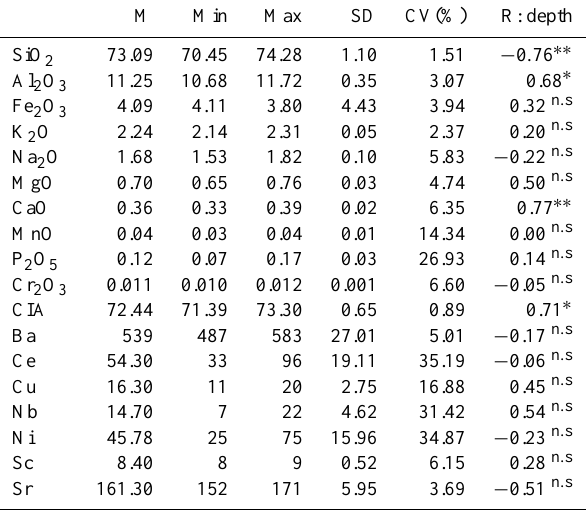
Table 3. Descriptive statistics and correlation with the depth of the geochemical elements and trace elements analysed in the ADV.20 section. Significant differences at p < 0 . 05 ∗ , p < 0 . 001 ∗∗ , n.s. not significant at a p < 0 . 05 ( N = 10).